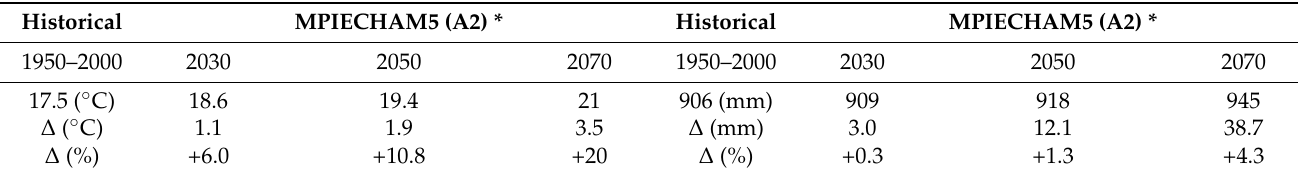
Table 5. Trend and increase in temperature and precipitation of emission scenario A2 in the